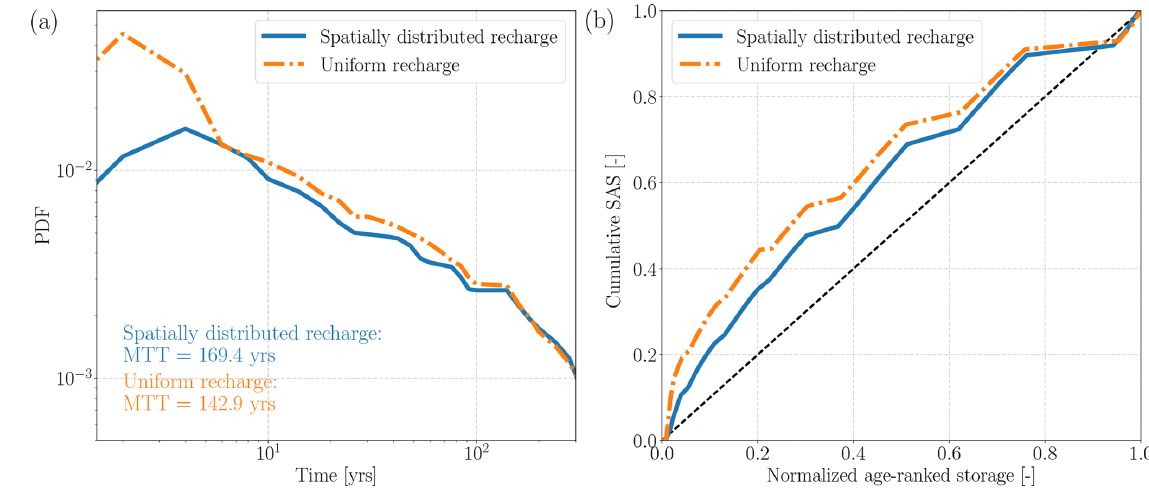
Figure 10. Sensitivity of (a) TTDs and MTTs and (b) SAS functions to the spatial pattern of recharge.